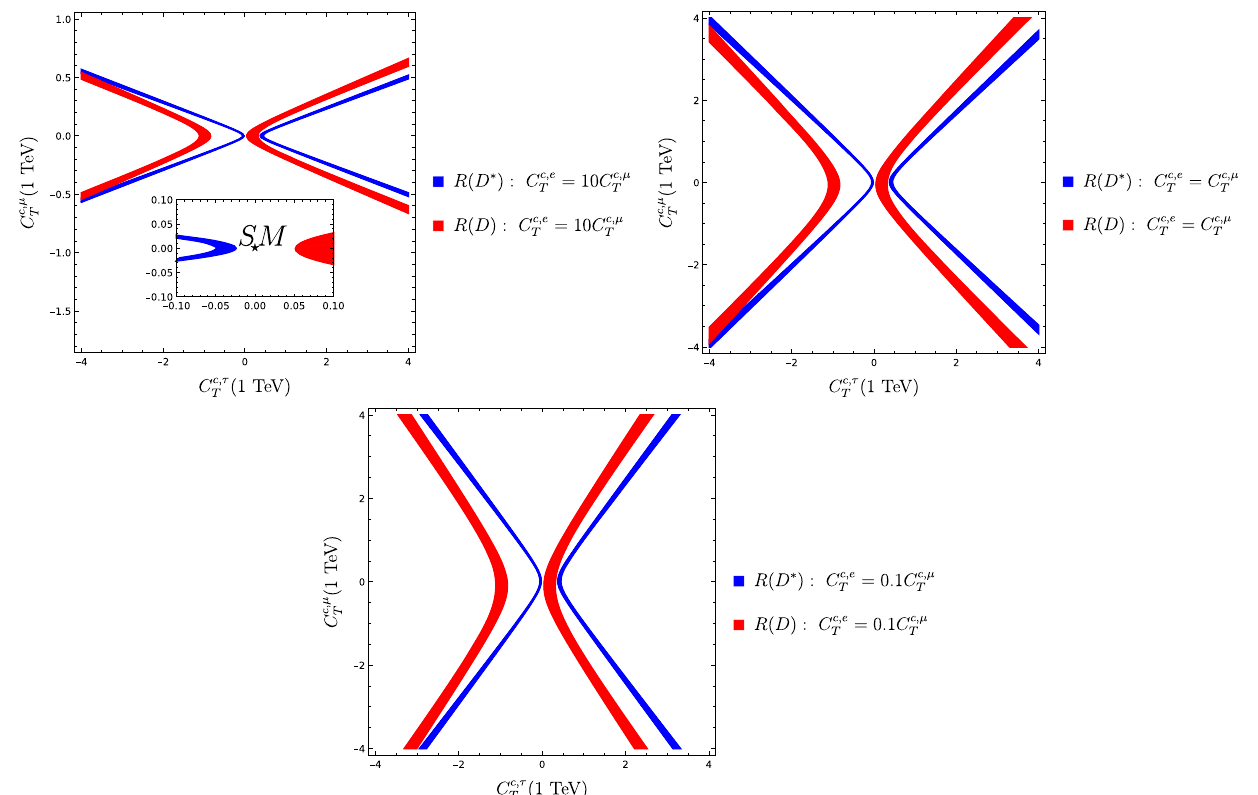
,μ – C c plane following from R ( D ) and R ( D ∗ ) , considering different correlations between the Wilson coefficients T T